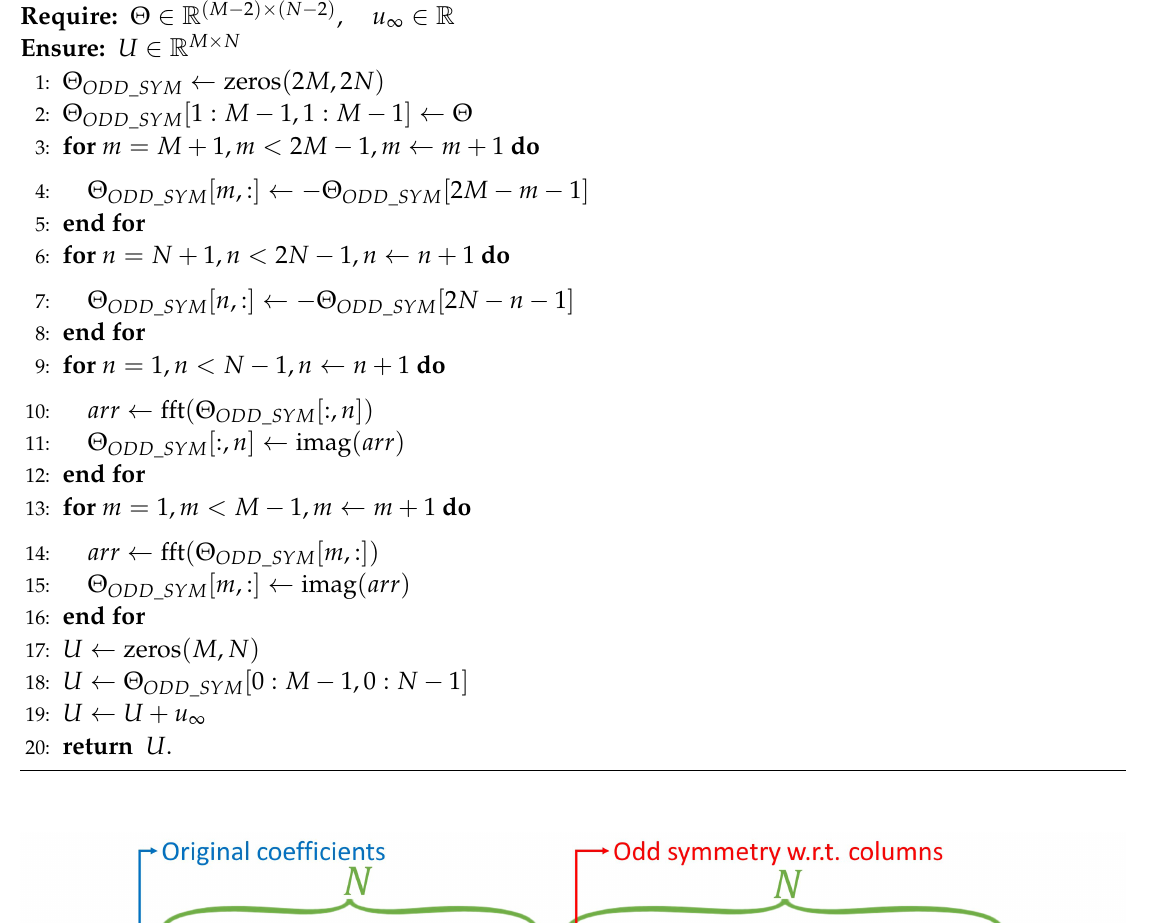
Algorithm 3 Retrieve temperature using 1D FFTs by applying odd symmetry to the original coefficients